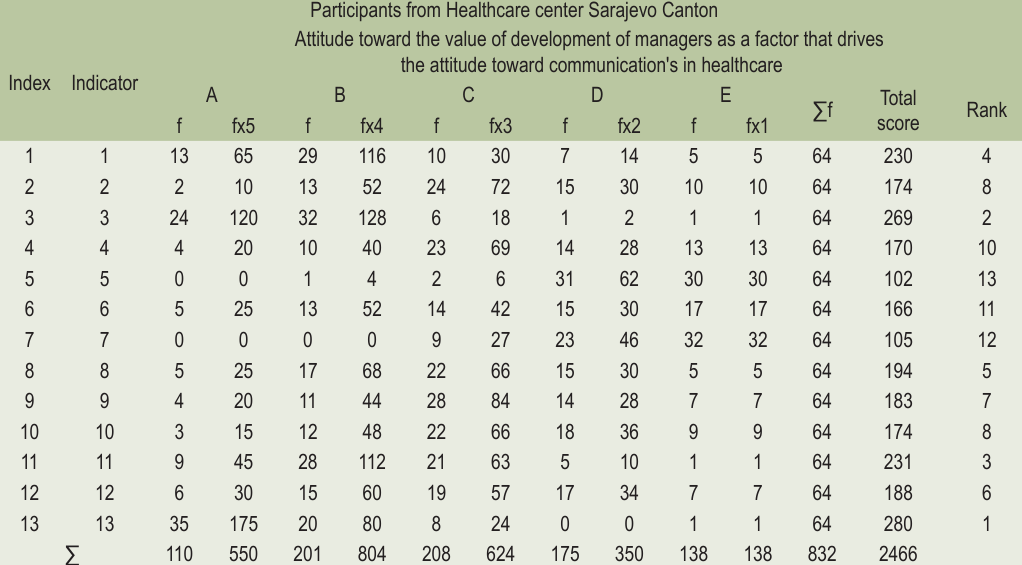
TABLE 4. Detail study results for Healthcare center Sarajevo